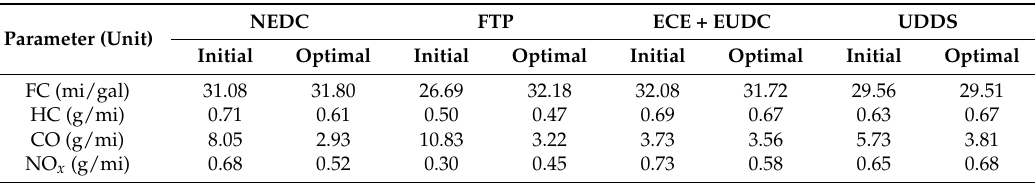
Figure 7. The histogram of fitness values for initial and optimal values of the parameters of the control strategy. Table 8. The result for fuel consumption (FC) and emissions using initial and optimal values of the parameters of the control strategy.